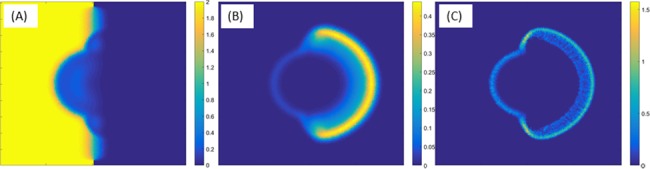
Simulation results for a plate in which only the left half of the domain initially has antibiotics.(A) The concentration of antibiotics, (B) P. vortex and (C) E. coli after 13hrs. The colony only grows to the right (no antibiotic) although in principle, the mixed colony can also grow to the left.